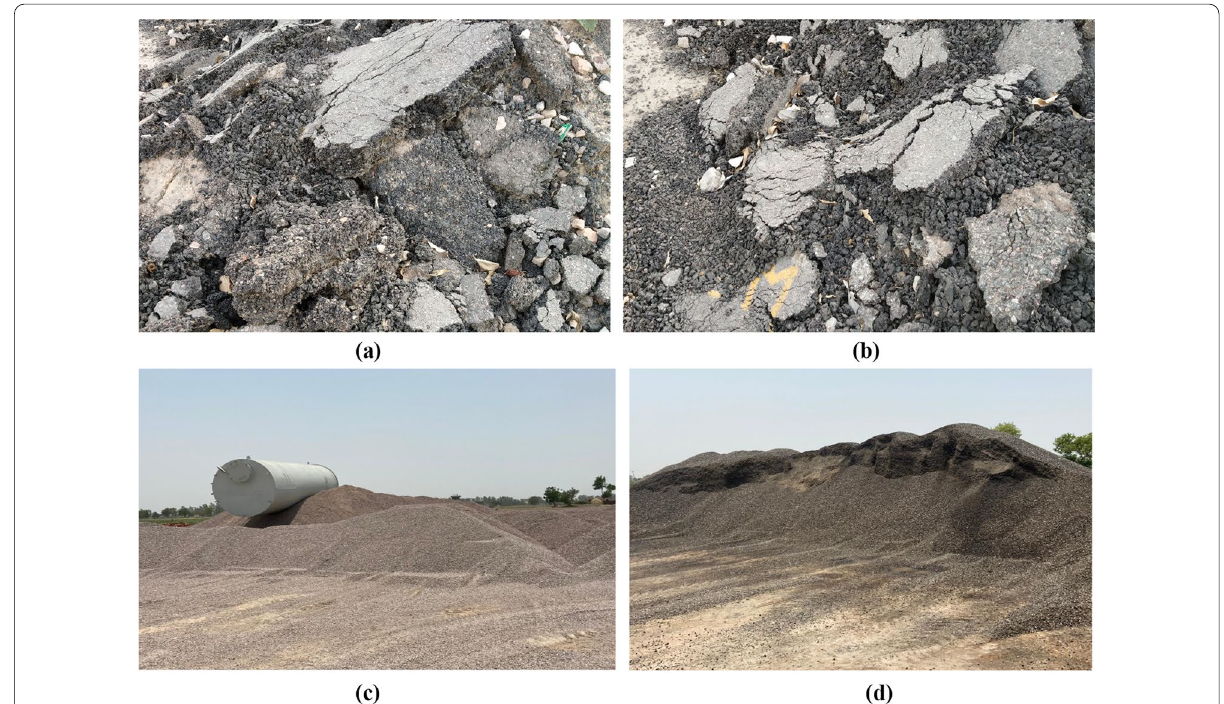
Fig. 1 a – d Milling of Narwana-Tohana road surface (MDR-112) and extraction of RAP